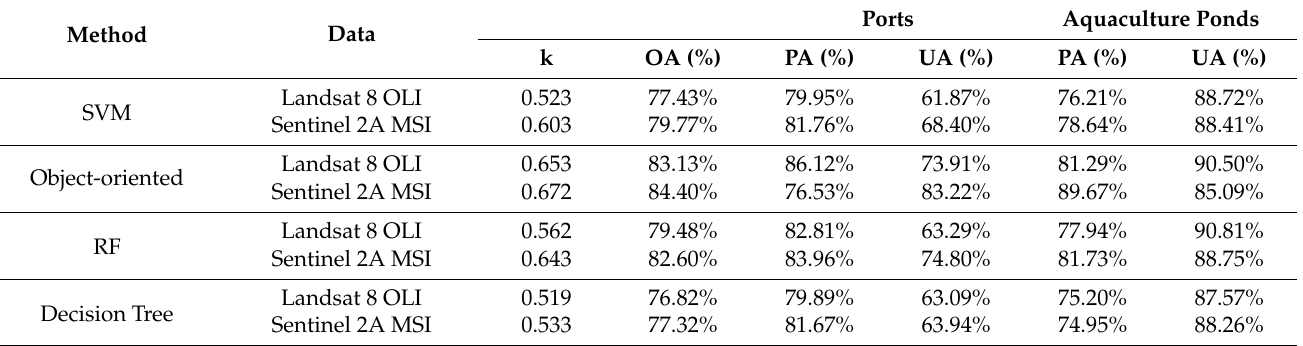
Table 9. Accuracy validation in east